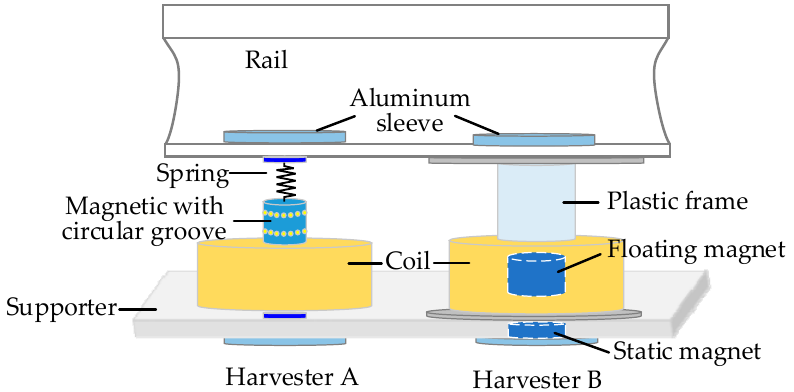
Figure 17. Electromagnetic energy harvesters: resonant Harvester A and magnetic levitation Harvester B.